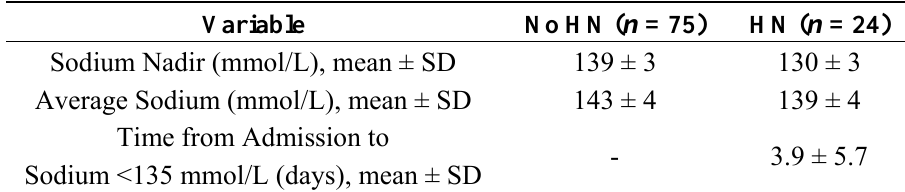
Table 2. Description of hyponatremia (HN).